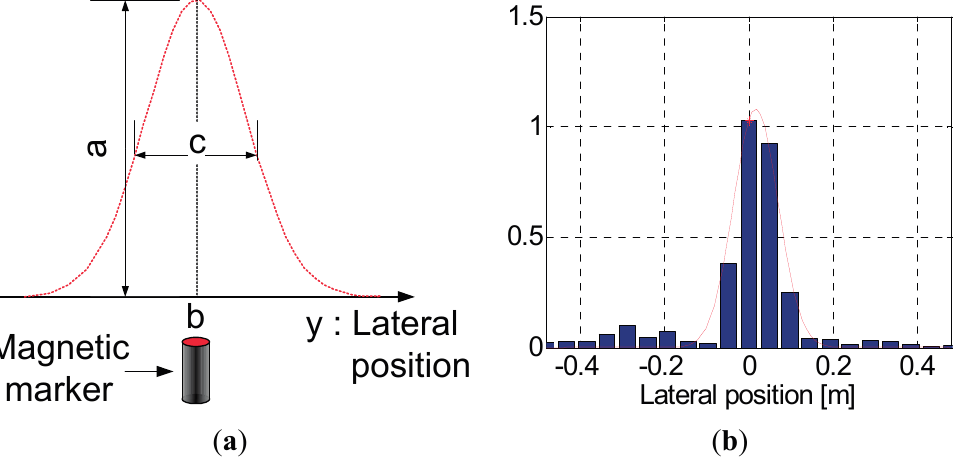
Figure 7. Gaussian function to characterize the MFS at the center of the magnetic marker: ( a ) Mathematical definition of a Gaussian function; ( b ) 1D discrete data measured by the sensor